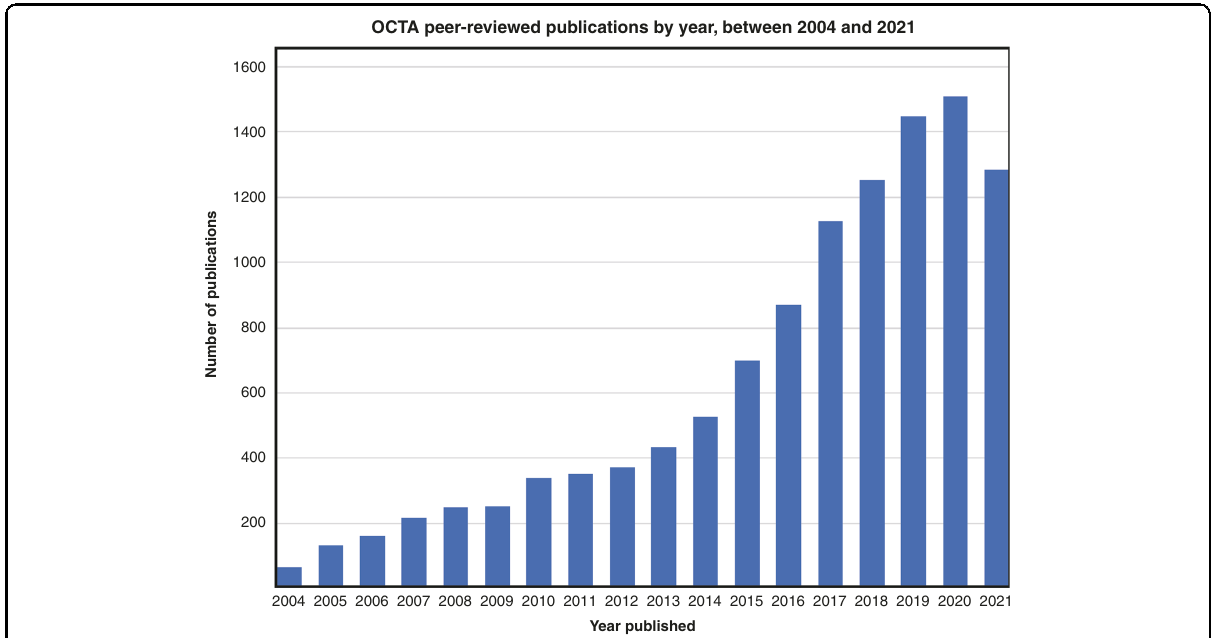
Fig. 1 Number of retinal optical coherence tomography angiography peer-reviewed publications by year since 2004. Data sourced: Pubmed, with “ optical coherence tomography angiography ” , “ OCT-angiography ” and “ retina ” as the search key words. Data retrieved on 28 January